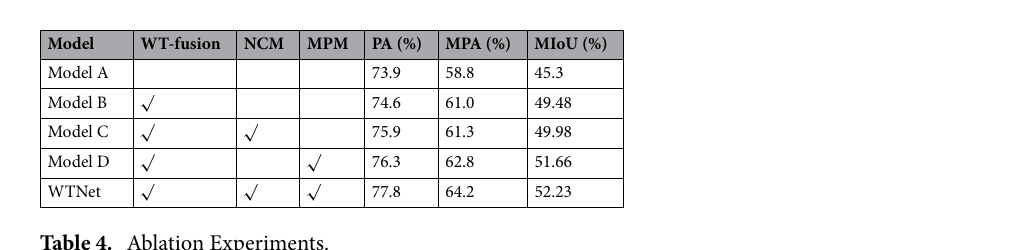
Table 4. Ablation